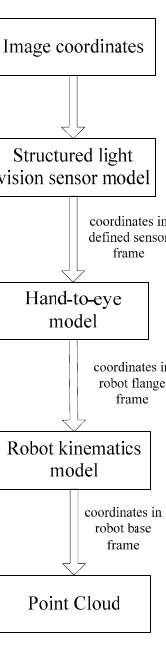
Figure 2. The presented 3D measurement system principle.